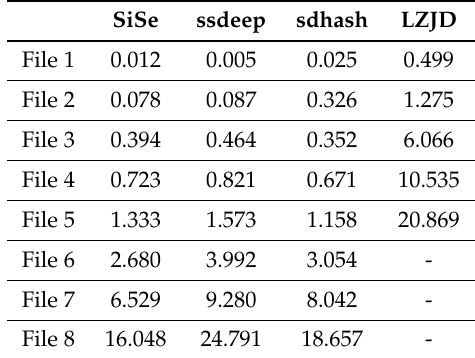
Table 26. Signature generation time in seconds with the set of eight files